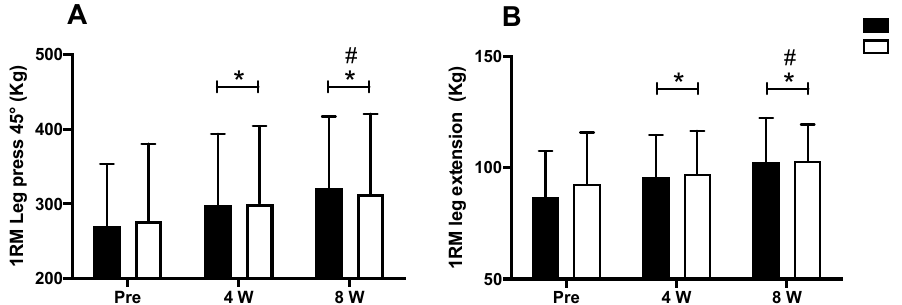
Figure 3. 1RM test in leg press 45° ( A ) and leg-extension exercises ( B ). HL: high-load resistance training, LL: low-load resistance training, Pre: test performed before eight weeks of training, 4 W: